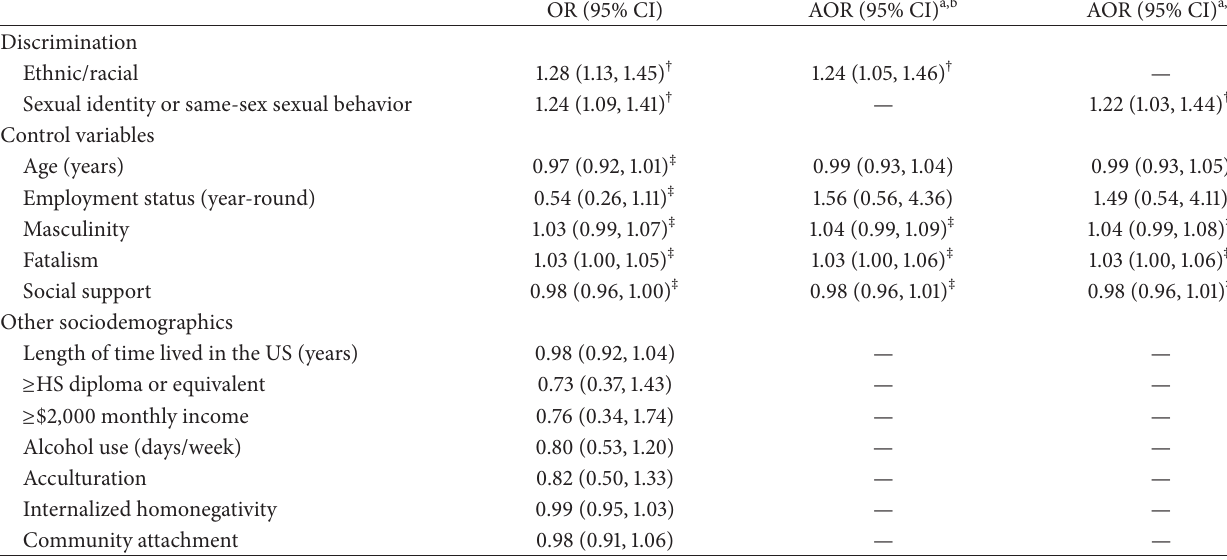
Table 2: Bivariable and multivariable associations with clinically significant depressive